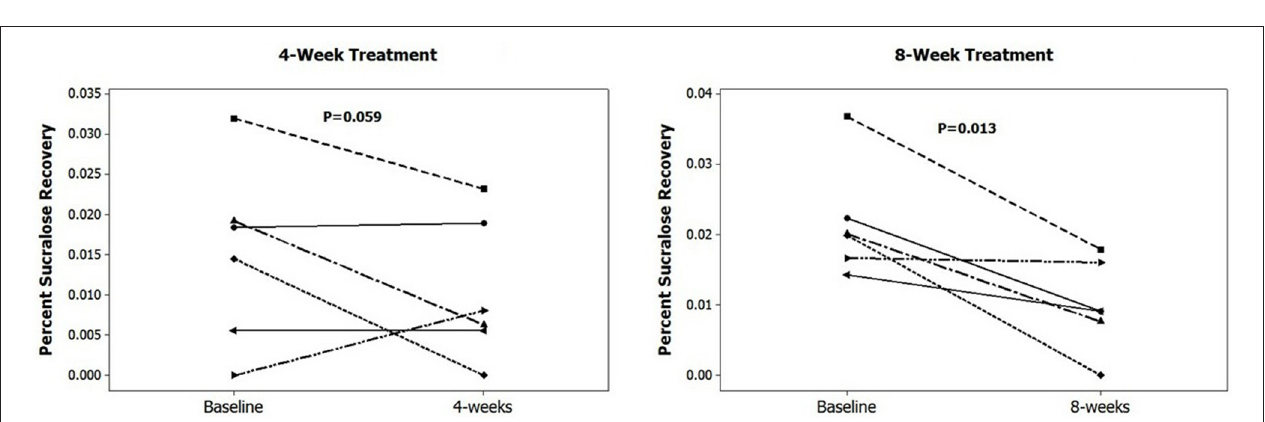
FIGURE 5 | Colonic permeability (percent sucralose recovery) of probiotic VSL#3 treatment in 4- and 8-weeks group.